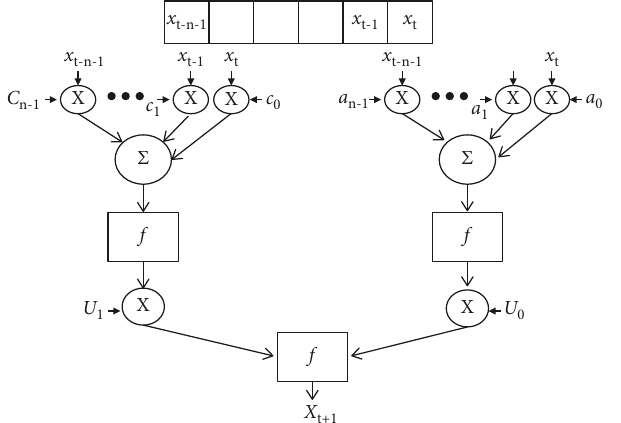
Figure 2: A hardware block diagram of a three-layer ANN.